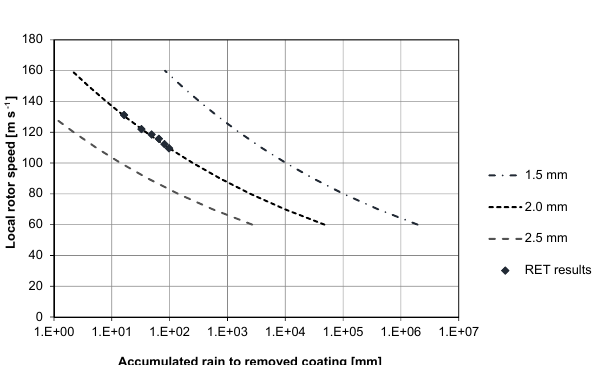
Figure 5. Wöhler curves for droplet diameters of 1.5, 2.0 and 2.5mm. Figure 6. Expected accumulated rain to remove coating as a func-